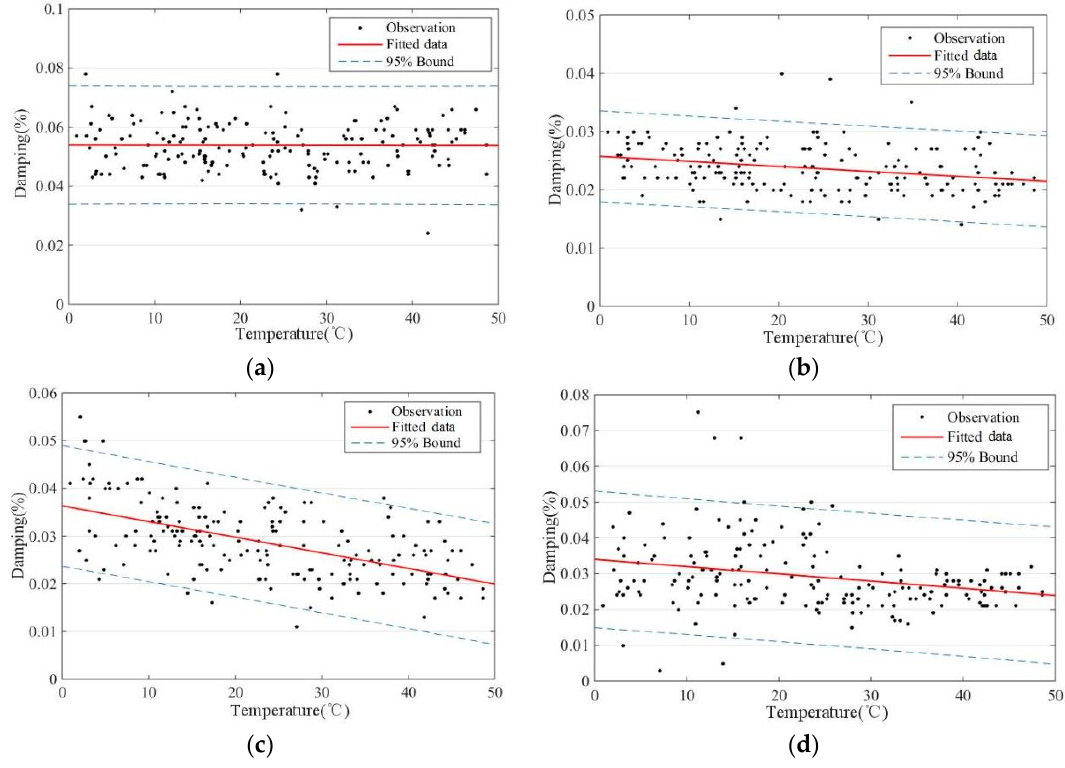
Figure 9. Damping ratio vs. temperature. ( a ) 1st mode. ( b ) 2nd mode. ( c ) 3rd mode. ( d ) 4th mode.